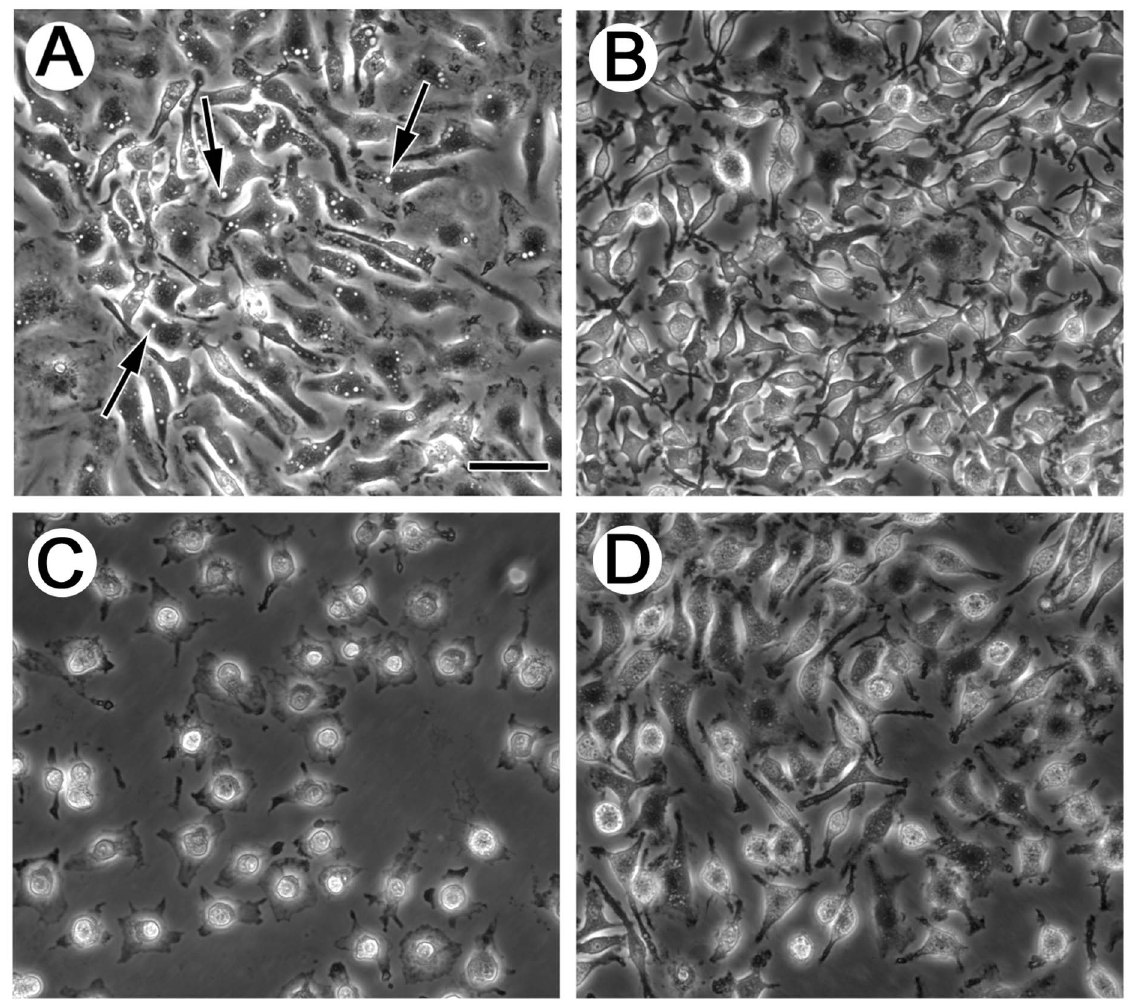
Figure 4. Macropinocytosis is inhibited by PI3K and actin polymerization inhibitors. Wild-type macrophages differentiated with M-CSF were pretreated 30 min with the drugs indicated below but without serum and M-CSF. Then, macrophages were treated 30 min with fresh serum- free medium containing M-CSF (50 ng/ml) in the presence of either DMSO vehicle (A), 100 nM wortmannin (B), 4 m g/ml cytochalasin D (C), or 50 m M LY294002 (D), and then examined by phase-contrast microscopy. Arrows indicate macropinosomes. Scale bar in A=75 m m and applies to all. (Also see Videos S5, S6, S7, S8).